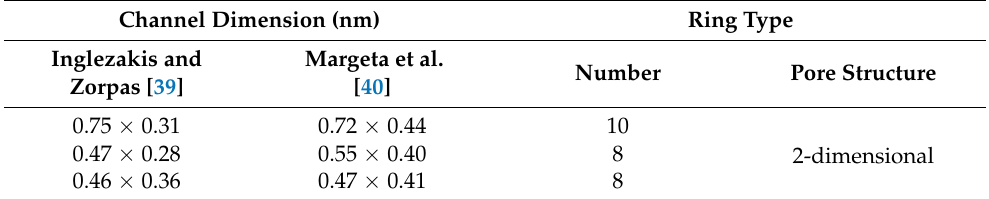
Table 5. Physical characteristics of the investigated cations. Cation